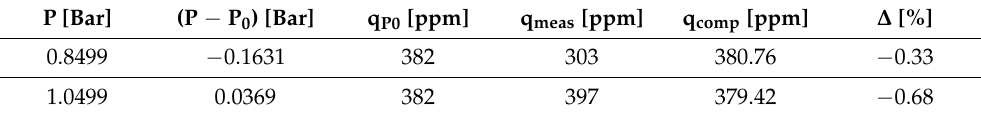
Table 1. Verification of the compensation algorithm performed on two arbitrary pressure points.